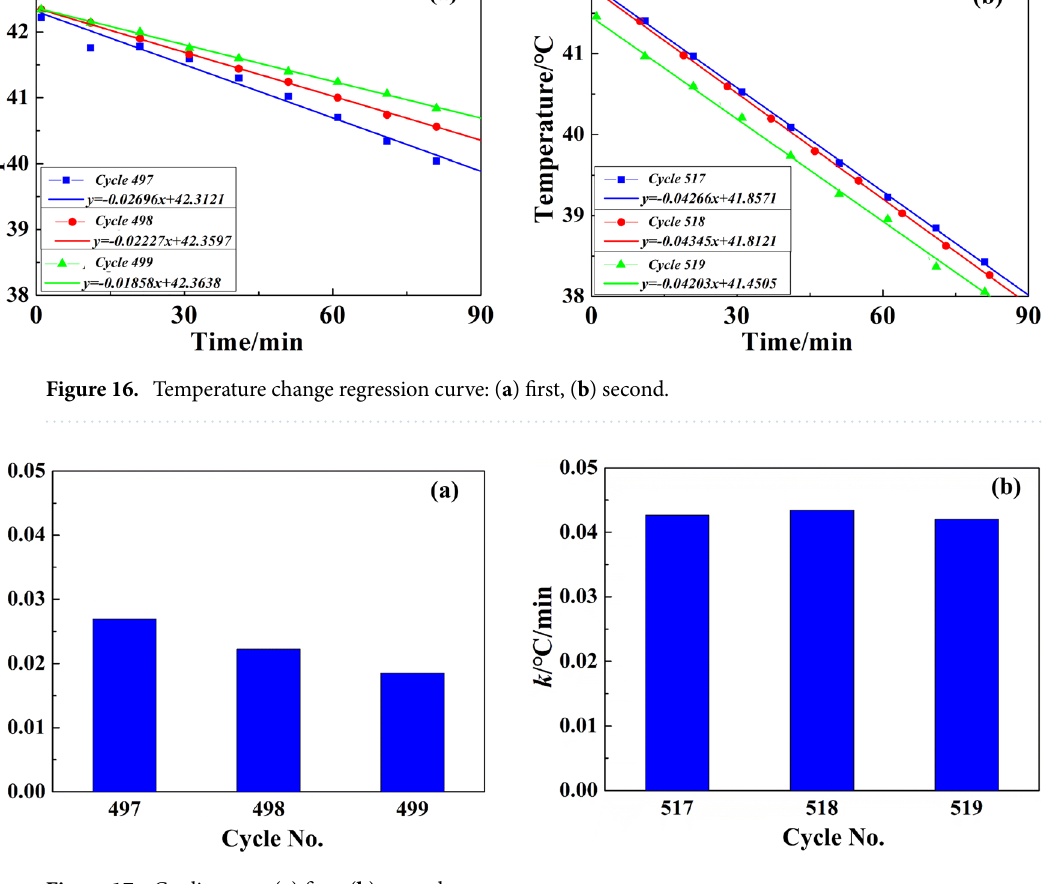
Figure 17. Cooling rate: ( a ) first, ( b ) second.